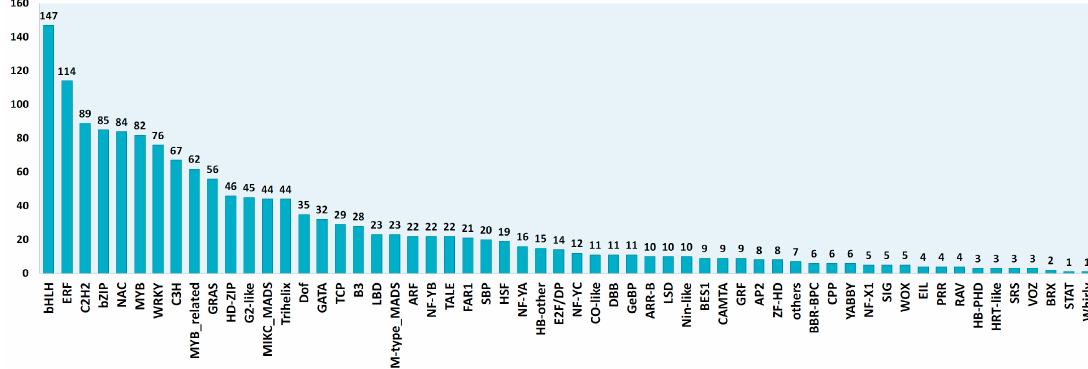
Figure 1. Identification and assignment of the 1560 transcription factors (TFs) expressed in the leaves of C. endivia according to the PlantTFDB rules [26].